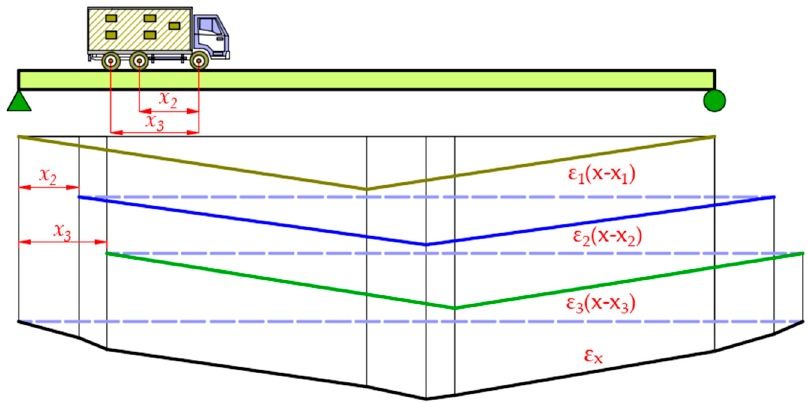
Figure 2. Mid-span strain influence line under moving load.